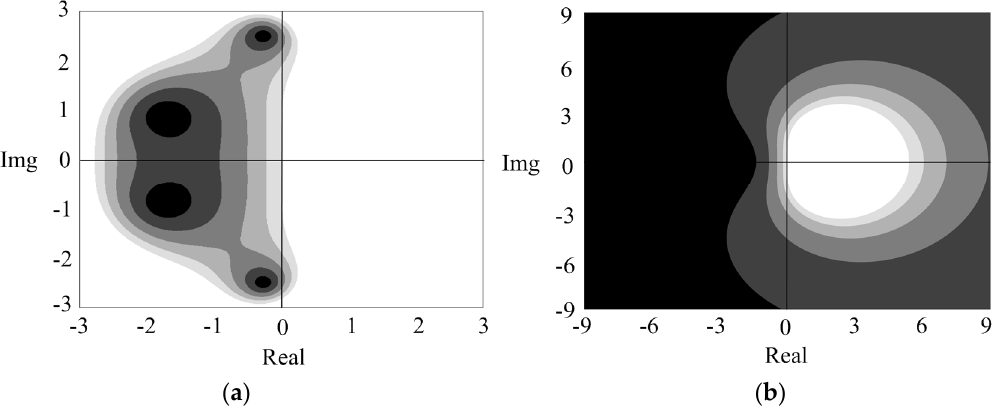
Figure 10. The unconditional stability region of fourth-order R-K and implicit RadauIIA: ( a ) fourth-order R-K; ( b ) implicit